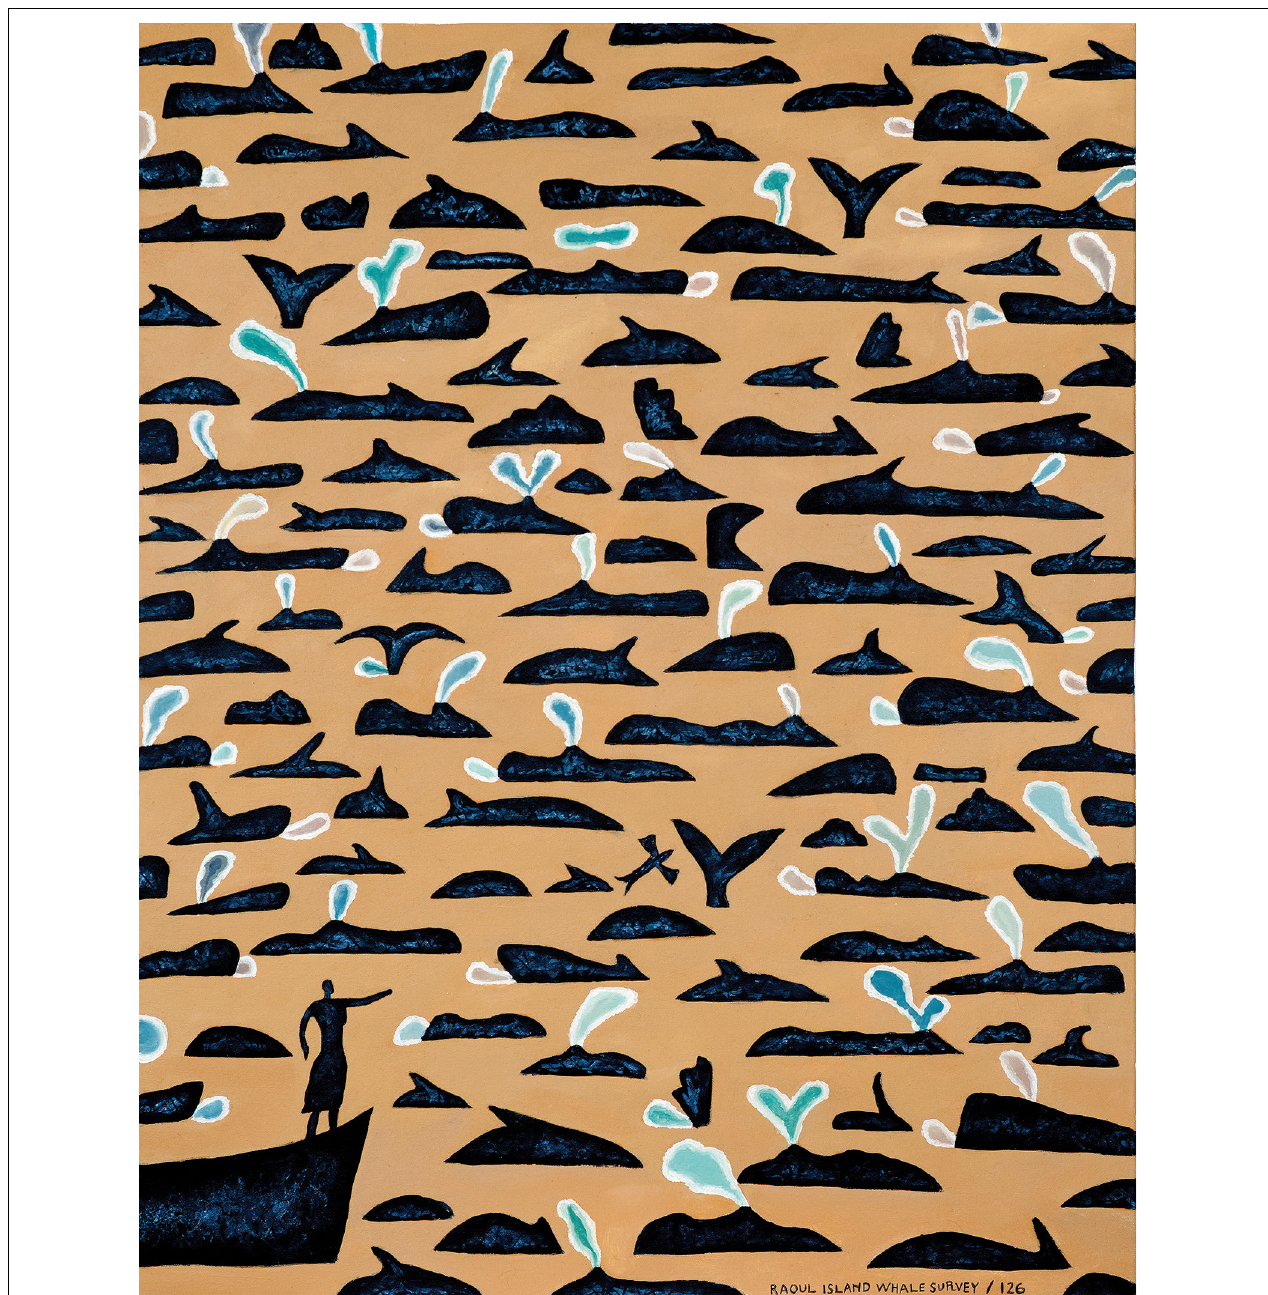
FIGURE 2 | Original artwork: Raoul Island Whale Survey 126, 2012 by Gregory O’Brien demonstrating the relationships between Indigenous peoples and marine megafauna, in this case the importance of whales to M¯aori people of Aotearoa – New Zealand. Used with permission. ©Gregory